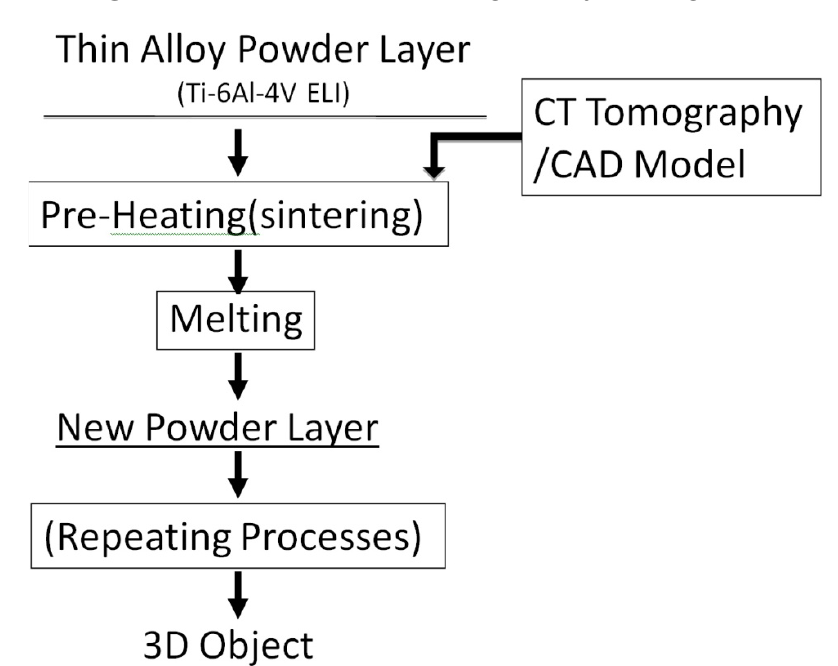
Figure 2. Flow sheet of fabricating 3D object using EBM.